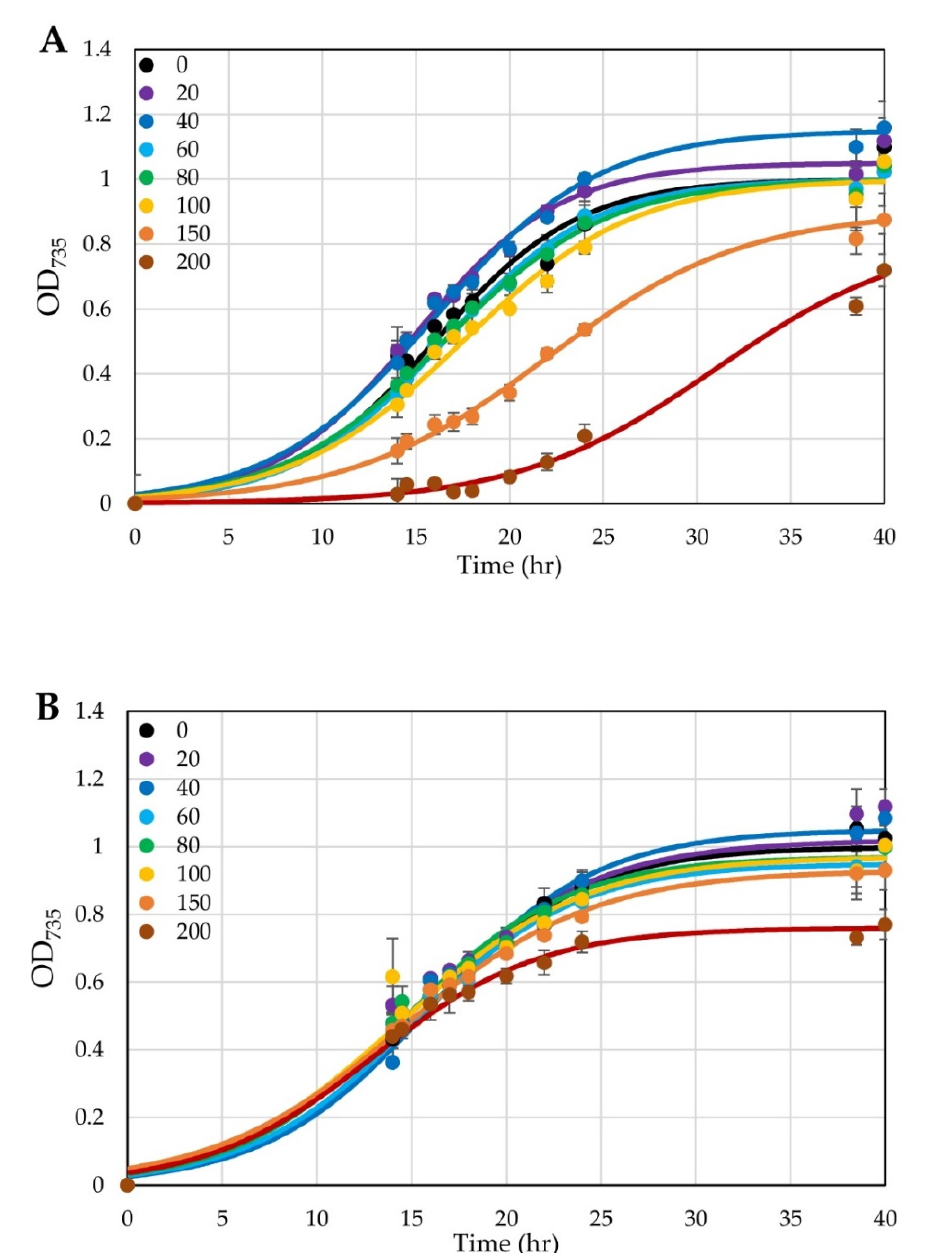
Figure 4. The effect of aTc on the growth of WT H. modesticaldum . Tested aTc concentrations ranged from 0 to 200 µ g L − 1 , as indicated in the legends; aTc was added either at the time of inoculation ( A ) or at 14.5 h ( B ). Each point represents the average of three replicates; error bars represent a standard deviation. Curves represent fittings to a logistic function